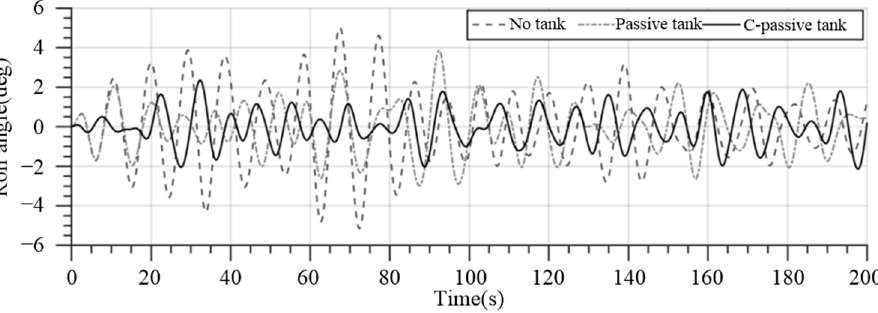
Figure 11. Roll angle of no tank, passive anti-rolling tank, and controllable passive anti-rolling tank.